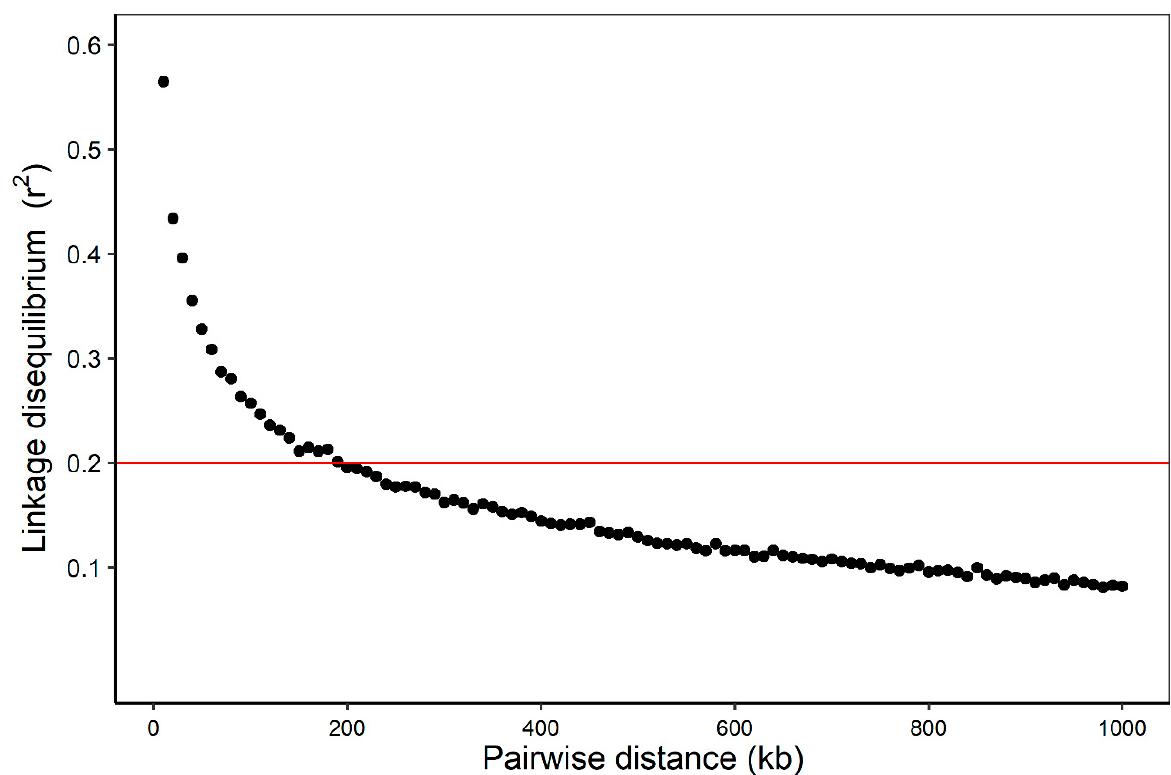
Figure 1. Linkage disequilibrium decay across the whole genome of the association panel. The red line represents the linkage disequilibrium threshold for the association panel ( r 2 = 0.2).